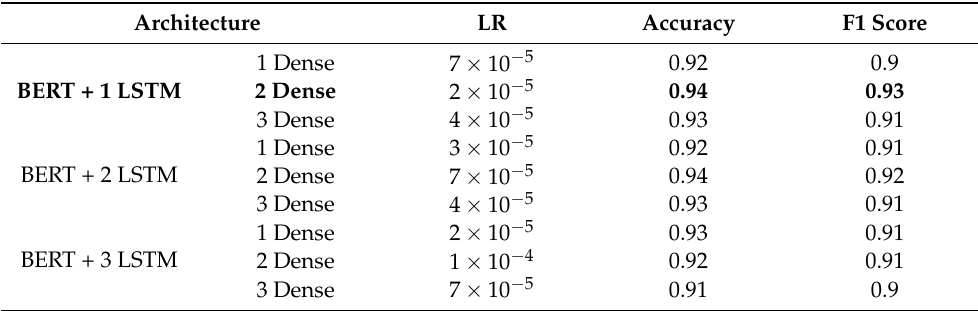
Table 3. Comparing BERT + LSTM Classifier results. (Bold text indicates the model parameters achieving the highest accuracy.)